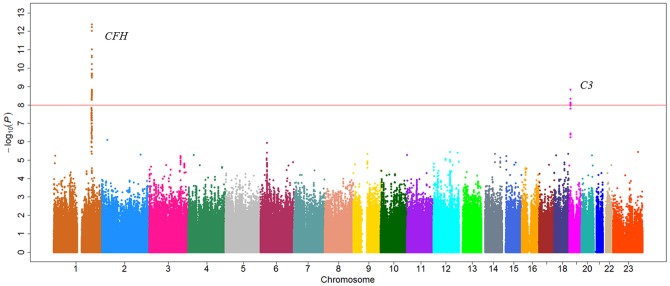
Manhattan plot of genome-wide association analyses for C3 level.X-axis shows chromosomal positions. Y-axis shows –log10
P-values from linear regression adjusted for age, smoking, and logBMI. The horizontal solid line indicates the preset threshold of P = 5×10−8.